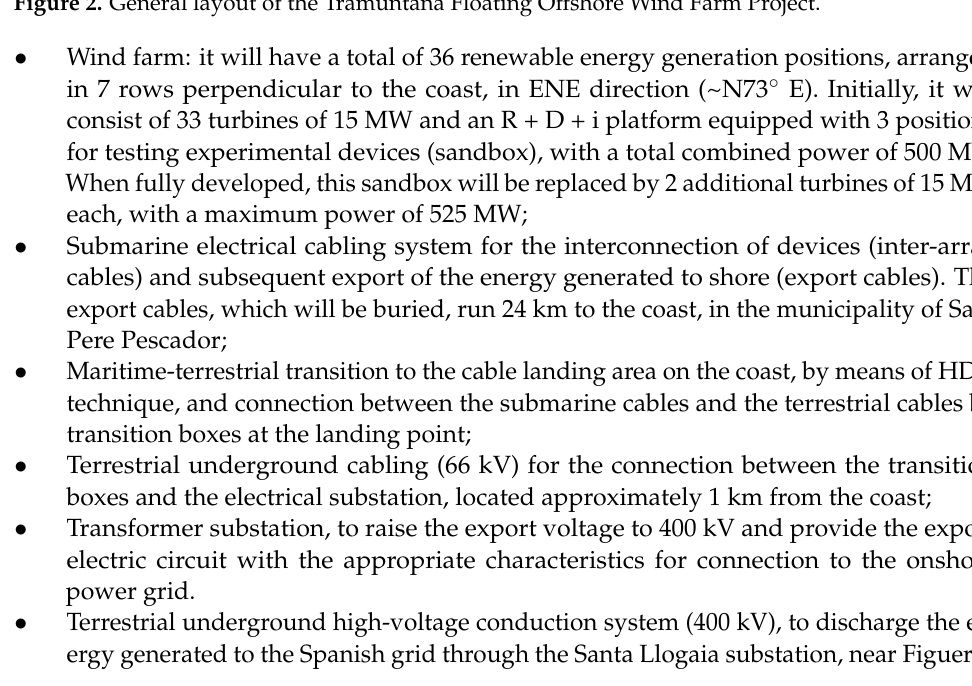
Figure 2. General layout of the Tramuntana Floating Offshore Wind Farm Project.